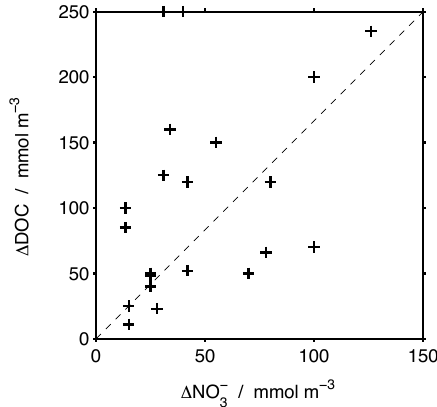
Fig. 8. DOC accumulation observed as a function of net draw- down of nitrate in phytoplankton culture and mesocosm